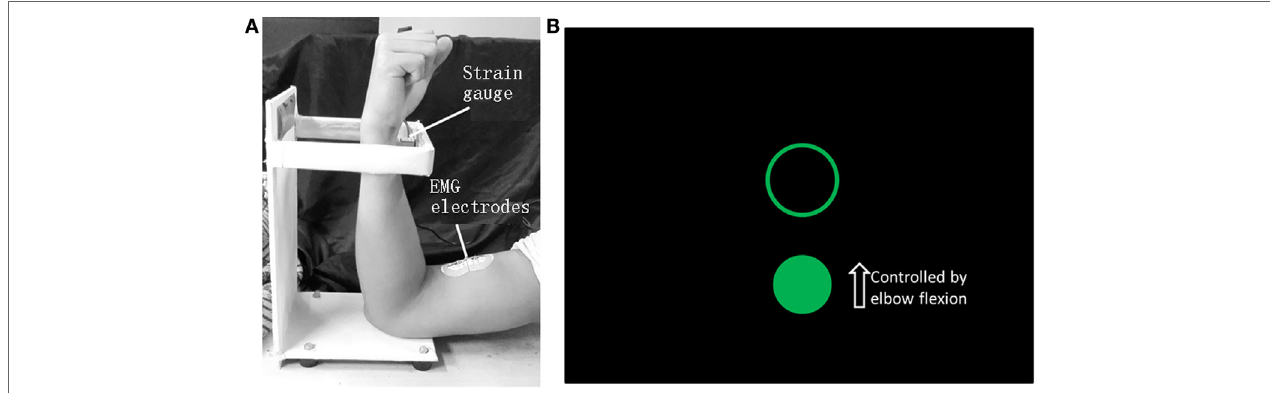
FIgURe 1 | The motion task of elbow flexion (a) and the visual feedback information on screen (B) . When the biceps brachii contracts, the wrist will press the strain gage and the force level can be detected. The circle can be shifted vertically by applying force to the strain gage and the position of the ring is fixed. The subject was requested to move the circle into the ring as soon as possible when a trial started and maintain the force until the end of a trial when the circle and the ring both disappeared. The force needed to shift the circle into the ring was 3